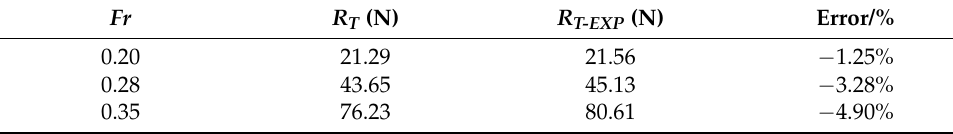
Table 8. Resistance value of the ship at each speed (number of grids was 7 × 10 5 ). Fr R T (N) R T-EXP (N)